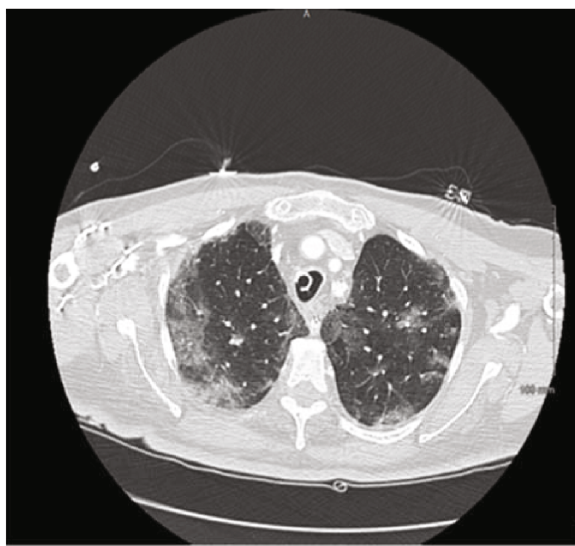
Figure 4: CT scan: bilateral ground glass